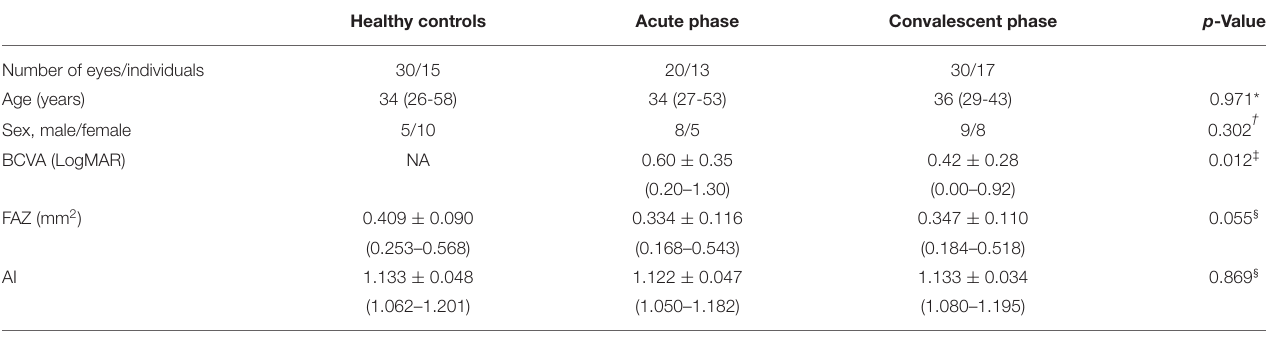
TABLE 1 | Demographic and clinical characteristics of study groups.